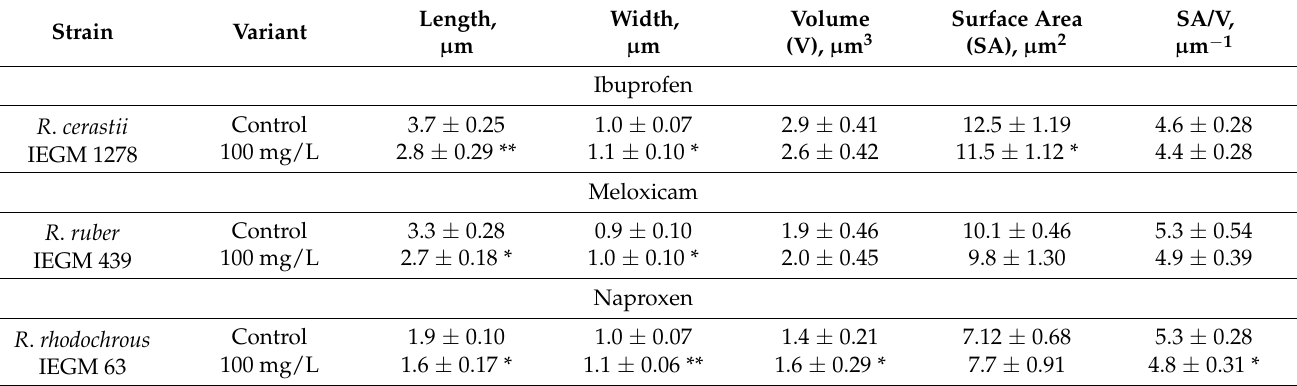
Table 2. Morphometric characteristics of rhodococci exposed to